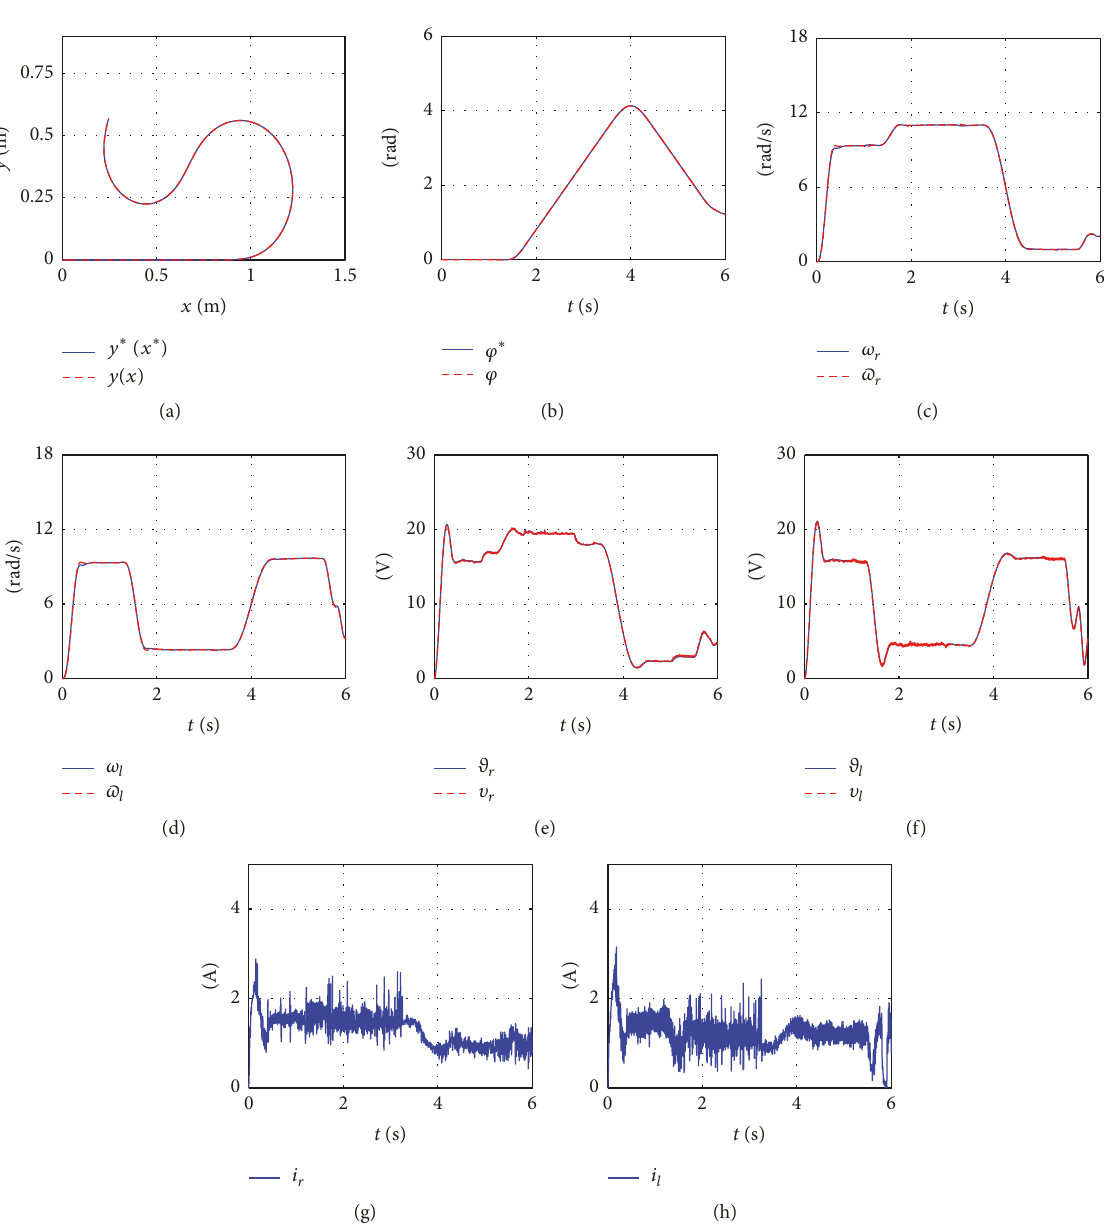
Figure 7: Experimental results when abrupt changes associated with 𝐿 𝑟 , 𝐶 𝑟 , 𝐿 𝑙 , and 𝐶 𝑙